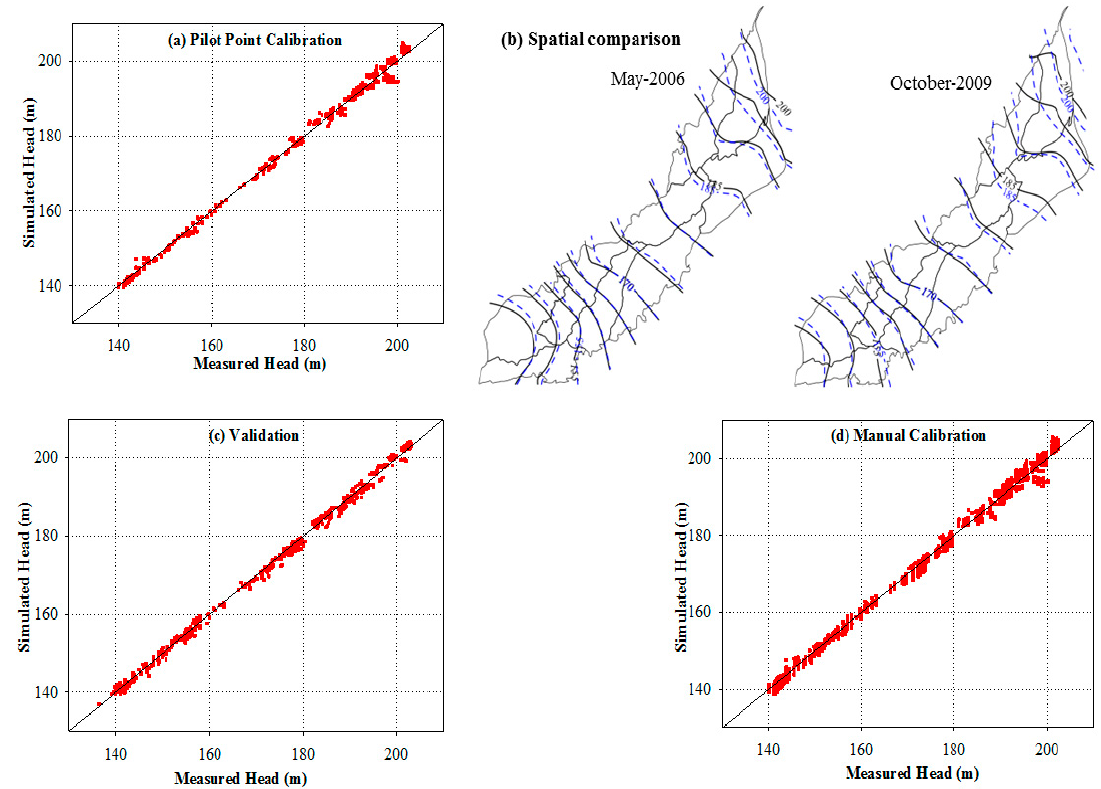
Figure 8. ( a ) Scatter plot for automated pilot point calibration; ( b ) spatial comparison between simulated and measured heads (layer 1); ( c ) validation; and ( d ) manual PP calibration.